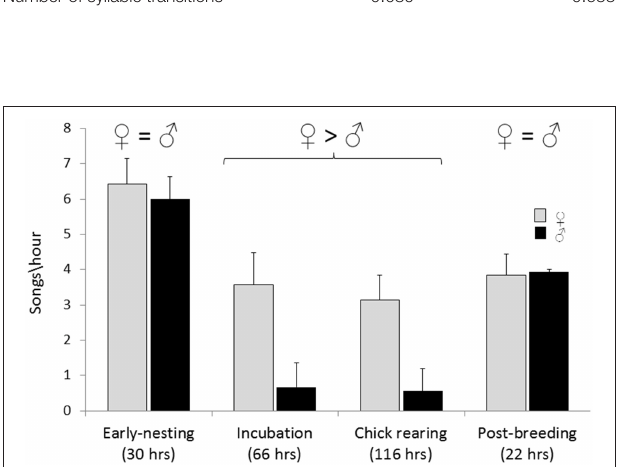
FIGURE 3 | Spontaneous song rate (songs per hour) by males and females on nesting territories ( < 15m from the nest site) based on 234h of observations of 26 nests. Wilcoxon signed-rank tests were used to compare song rates of males and female within each breeding stage. For early-nesting and post-breeding stages the differences were non-significant, and for incubation and chick-rearing stages female song rates were significantly greater than male song rates, W = 0, P <